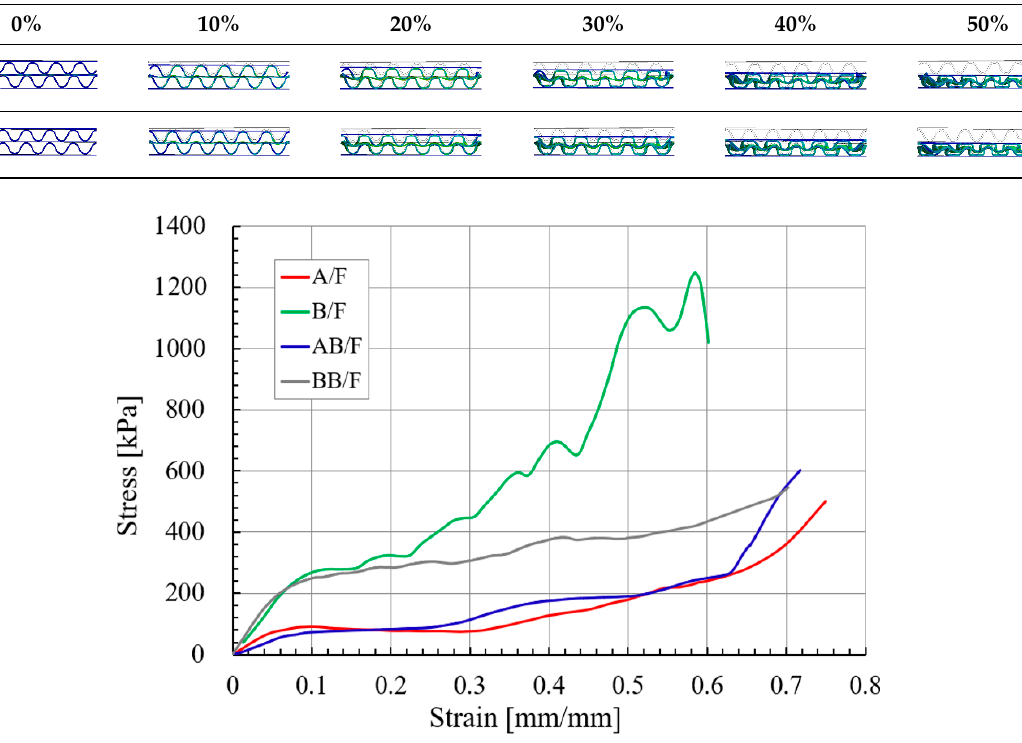
Figure 5. SS curves of the corrugated paperboard by flute type obtained using FEA.